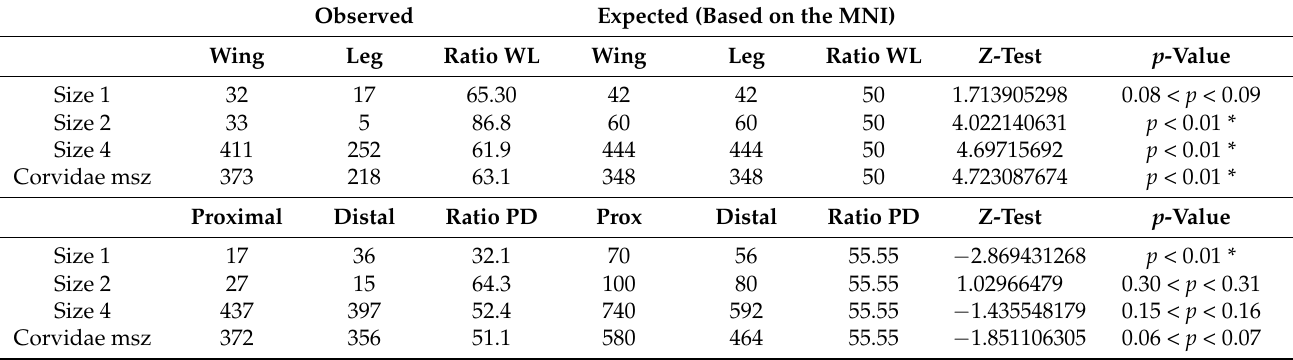
Table A3. Wing-to-leg (WL) and proximal-to-distal (PD) bone ratios, considering the total observed and expected remains. The classification by size was evaluated considering the bird’s weight (see Section 2). The ratios were only calculated for those categories for which the number of remains was large enough to obtain reliable results. A Z-test was calculated to see if the differences between the observed and expected elements are significant. * Significant. Msz: medium